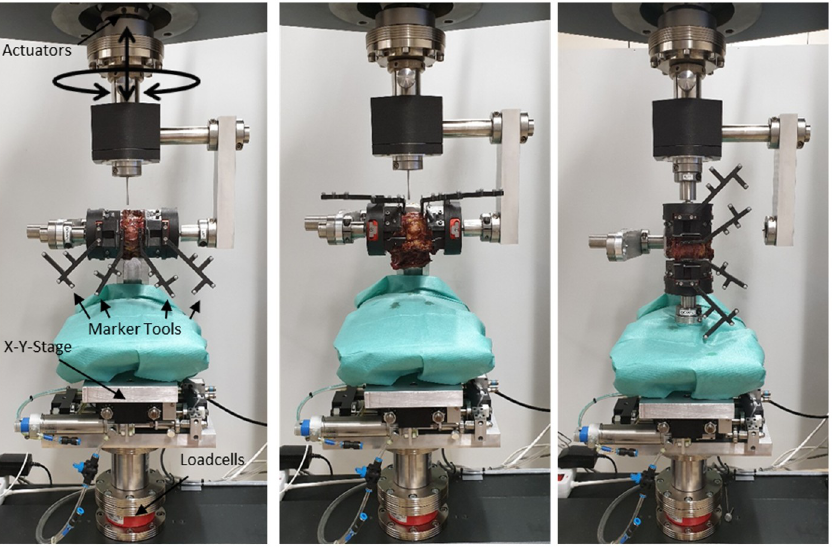
Fig 2. Mechanical test setup. The setup used for biomechanical testing can be used for flexion-extension and lateral shear (left), lateral bending and anteroposterior shear (center) and axial rotation and axial compression- decompression (right). Figure adapted from